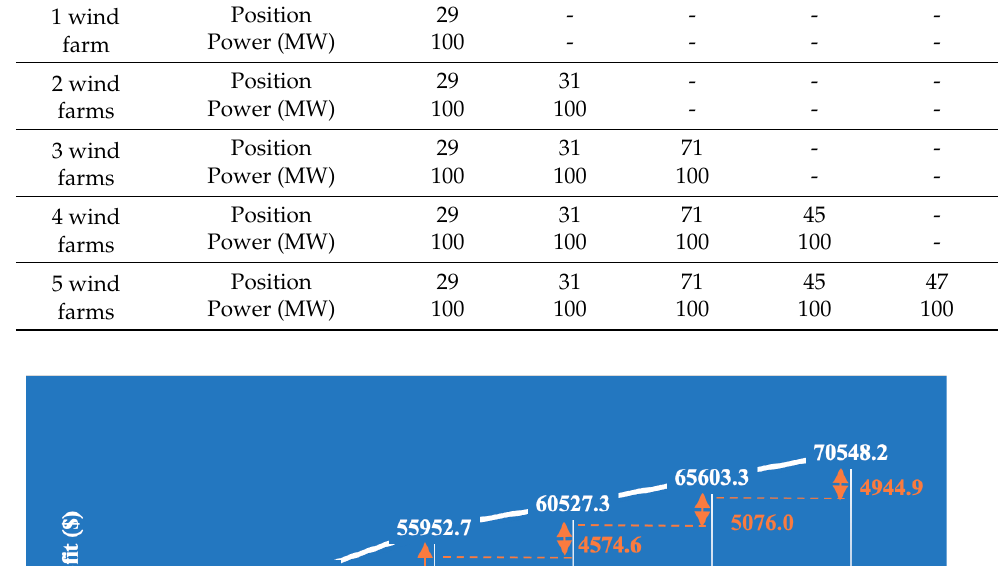
Table 4. Optimal solutions for the IEEE 118-node system.